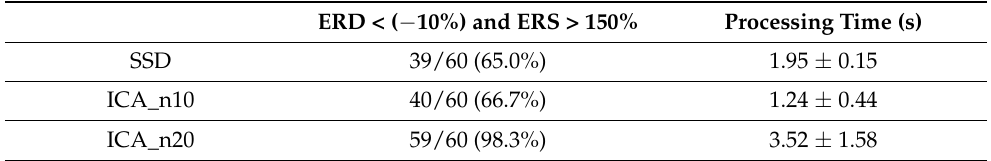
Table 2. Method verification with test